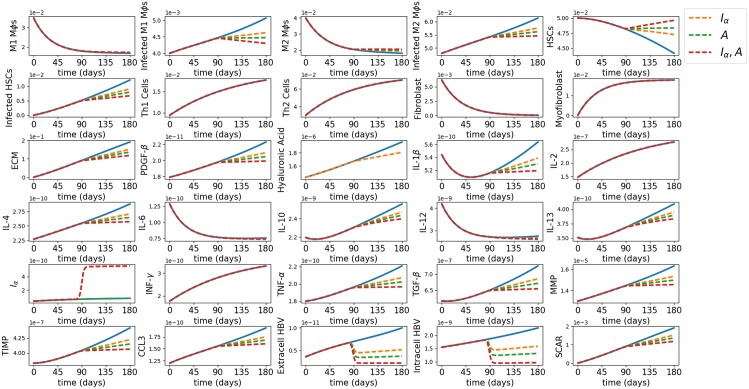
Monotherapy and combination therapy with IFN-α and adefovir.The horizontal axes scale the time in days and the vertical axes scale the average densities in g/cm3 for all the variables for the first 180 days since the start of the disease, in control case (blue) and with treatment (IFN-α–orange, adefovir–blue and combination–red).